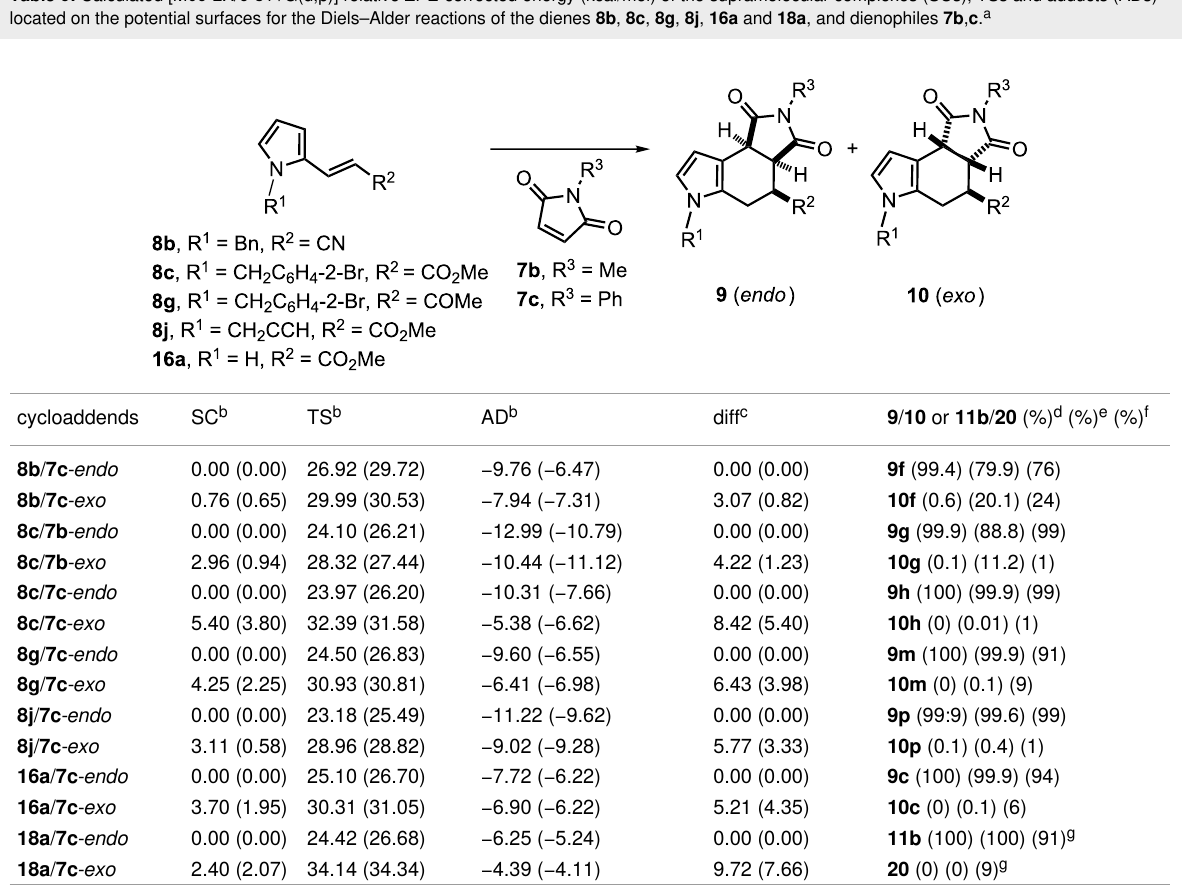
Table 6: Calculated [M06-2X/6-31+G(d,p)] relative ZPE-corrected energy (kcal/mol) of the supramolecular complexes (SCs), TSs and adducts (ADs) located on the potential surfaces for the Diels–Alder reactions of the dienes 8b , 8c , 8g , 8j , 16a and 18a , and dienophiles 7b , c . a